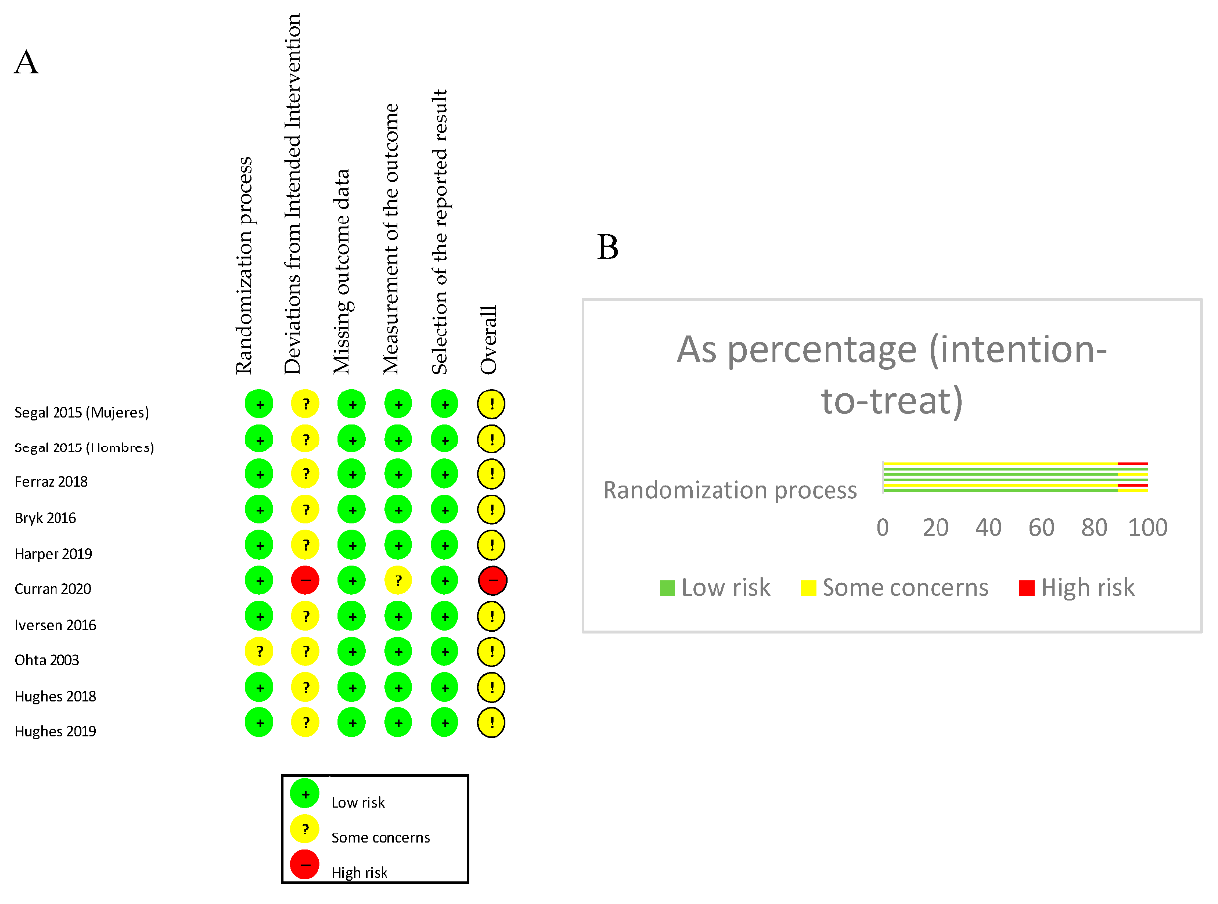
Figure 2. ( A ): Assessment of risk of bias. ( B ): Summary risk of bias by percentage. Secondly, each RCT was analyzed based on the PEDro scale [22,23]; a score equal to or greater than six was obtained in nine of the studies, which represents good methodological quality. Only one study’s methodology was classified as poor quality since its score was less than four points (Table